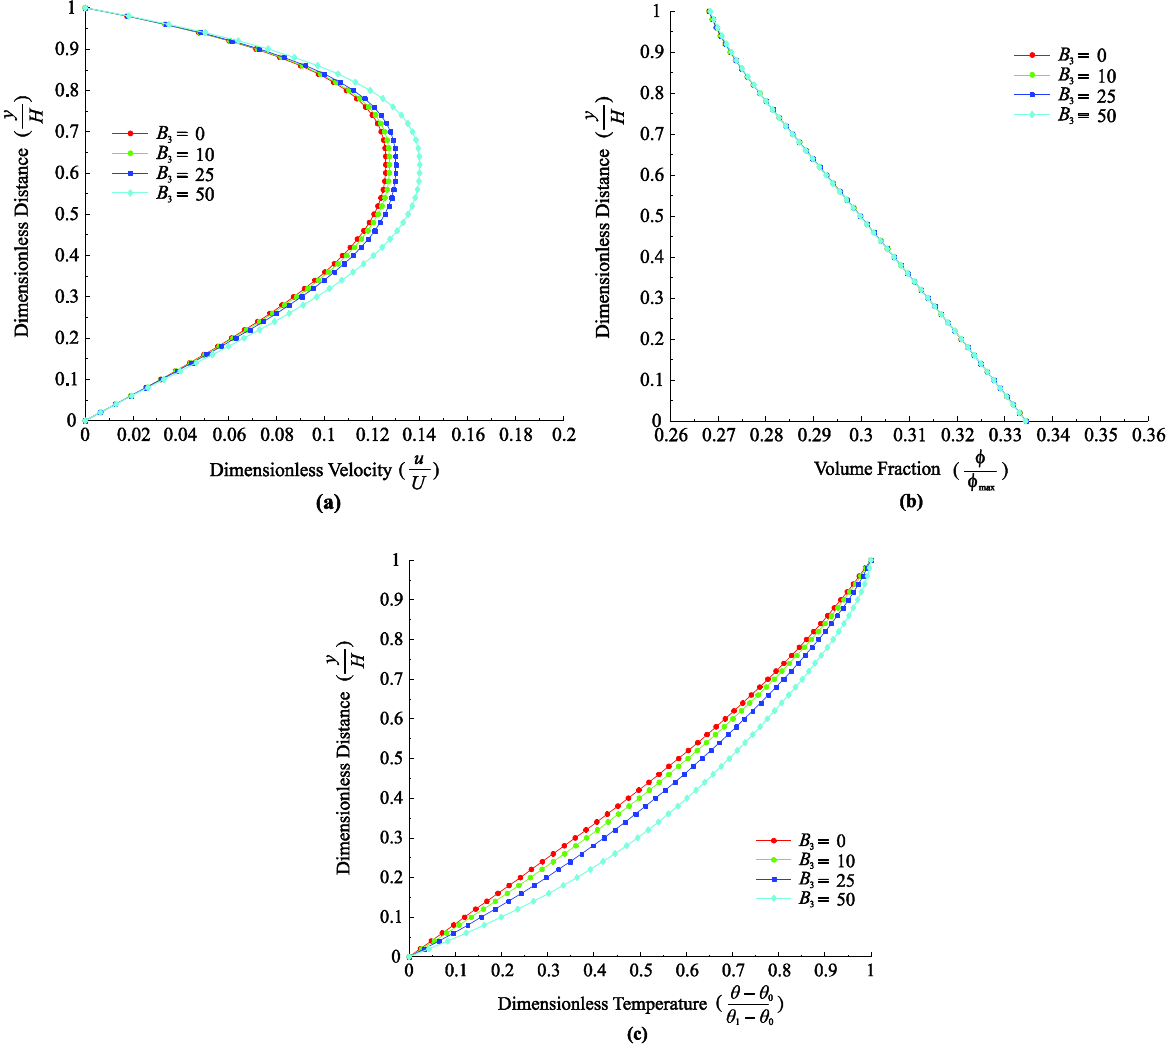
Figure 8. ( a ) Effect of 𝐵 volume fraction distribution. ( c ) Effect of 𝐵 𝑚 = −0.3, 𝑀 = 1, 𝐵 −0.02, 0.01, 2.3, −9, 11